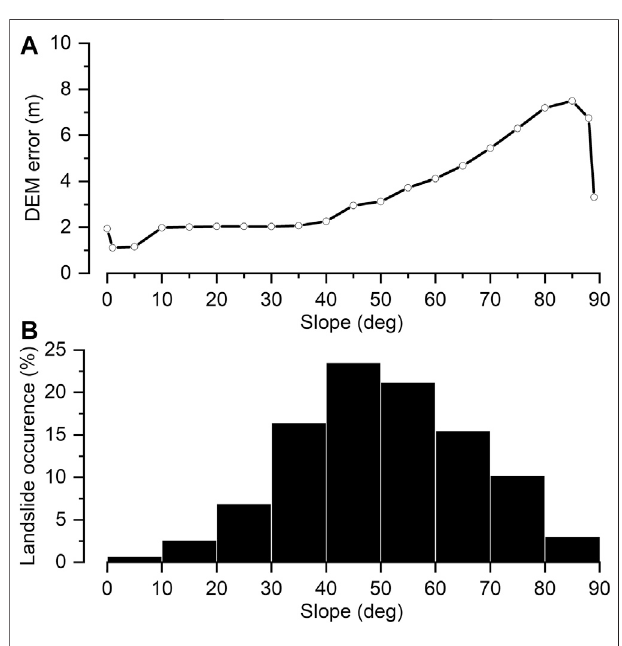
FIGURE 9 | DEM uncertainty plot. (A) Mean DEM error as a function of slope angle, (B) Distribution of landslides in different slope